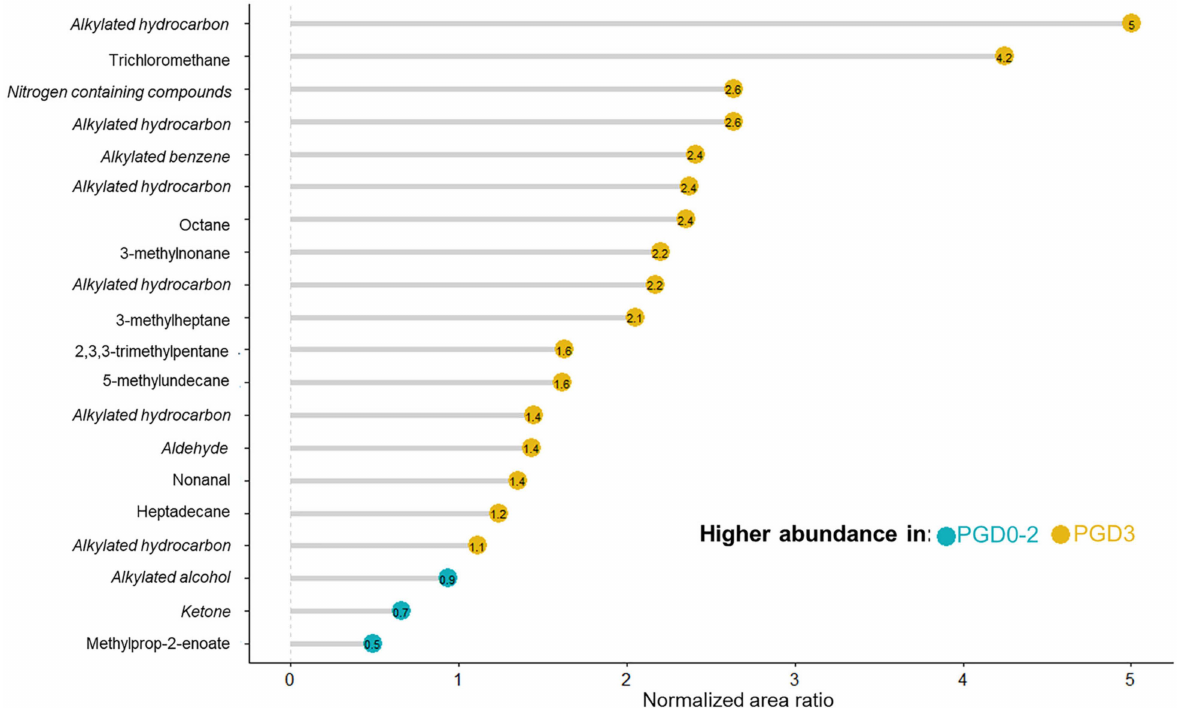
Figure 3. Ratio of the normalized areas of the 20 selected features. Reprinted from [36]